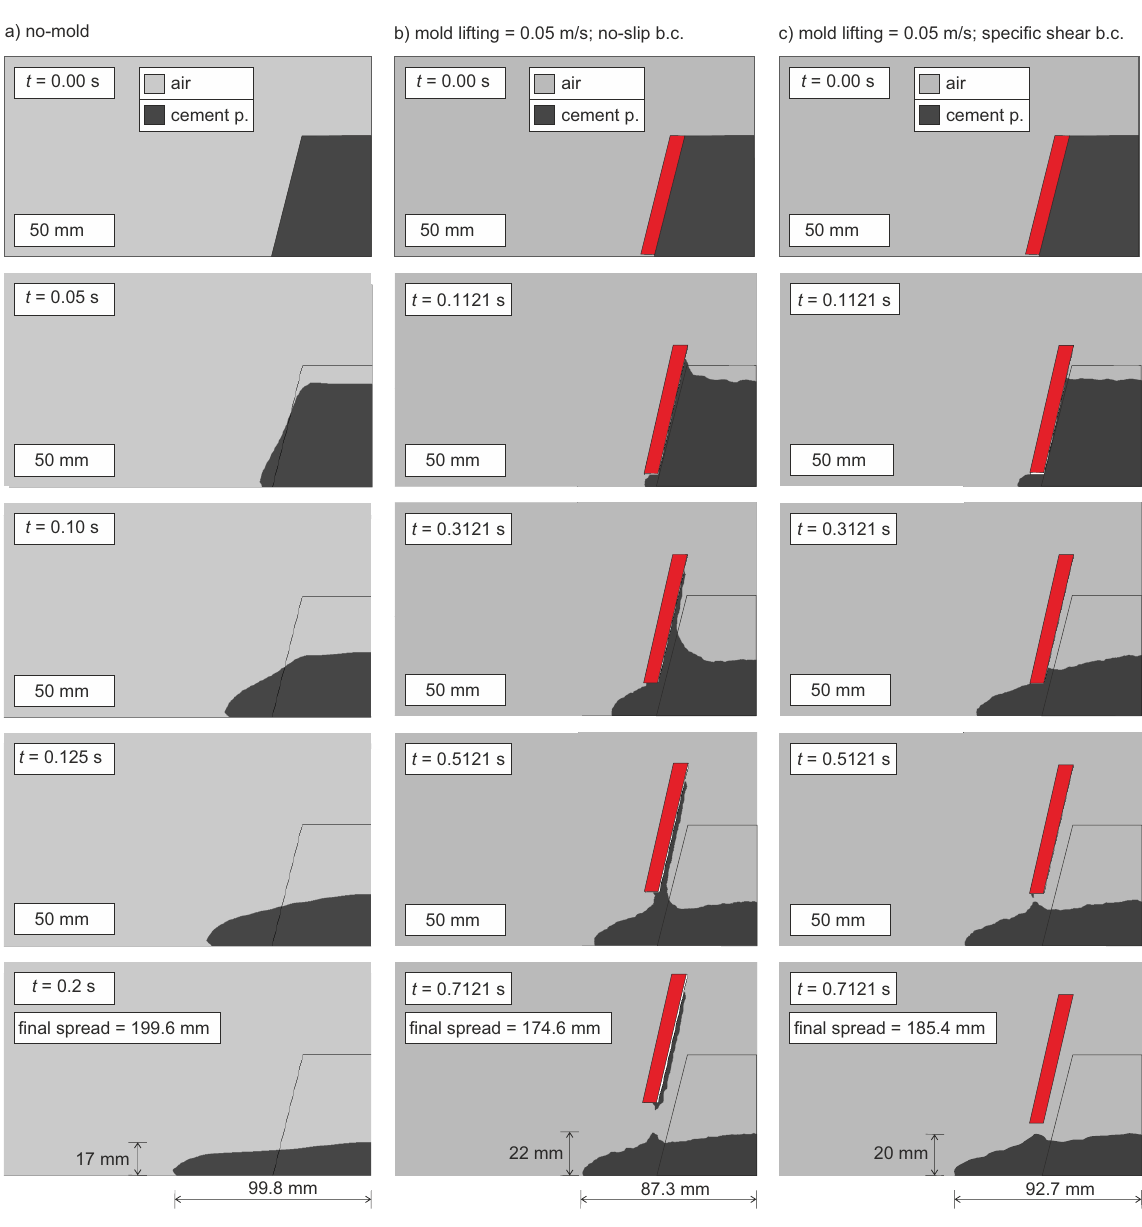
Figure 3. Results of calculation of mini-slump test in five di ff erent times: a) without mold b) with mold lifting ( v = 0.05 m/s) and no-slip b.c. c) with mold lifting ( v = 0.05 m/s) and specific shear b.c. on the mold (0.3 Pa).